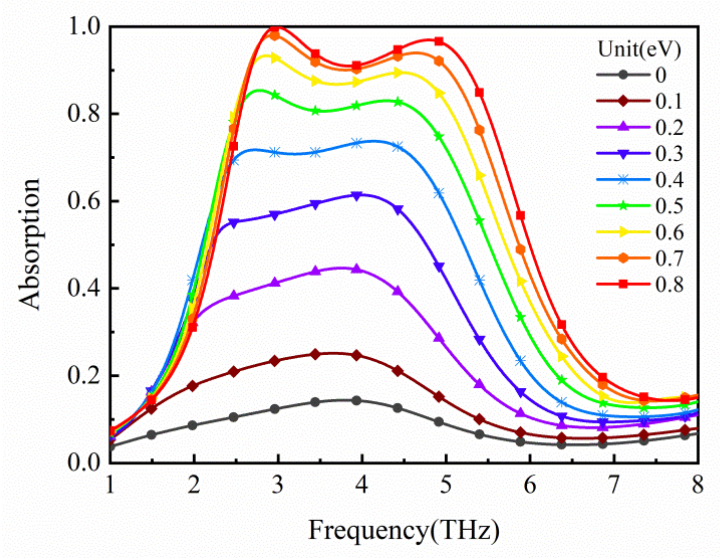
Figure 7. Absorption spectra of the proposed absorber with different Fermi levels E f of graphene (0–0.8 eV).